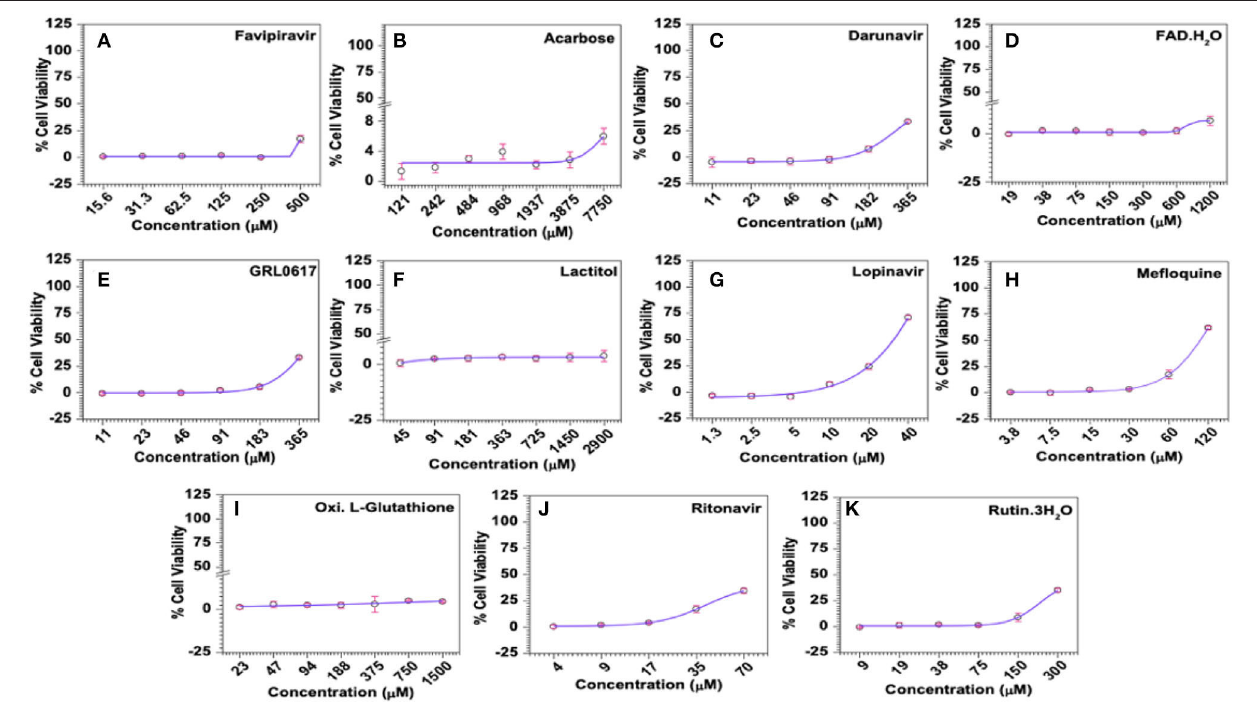
FIGURE 8 | Antiviral activities of selected compounds in MRC-5 cells in vitro . (A) Favipiravir (used as known reference control), (B) Acarbose, (C) Darunavir, (D) FAD hydrate, (E) GRL0617, (F) Lactitol, (G) Lopinavir, (H) Mefloquine, (I) Oxidized L-Glutathione, (J) Ritonavir, and (K) Rutintrihydrate were incubated with MRC-5 cells at the indicated concentrations for 6 days at 37 ◦ C in a CO 2 incubator and the antiviral activities of the compounds represented as the percentage of cells protected from virus-induced CPE was analysed quantitatively by the colorimetric MTT assay as described in Methods. The raw data was converted to % cell viability and plotted against the indicated doses. Experimental data sets were modeled using a logistic regression model and the 50% effective concentrations (EC 50 ) were derived ( Supplementary Table 4